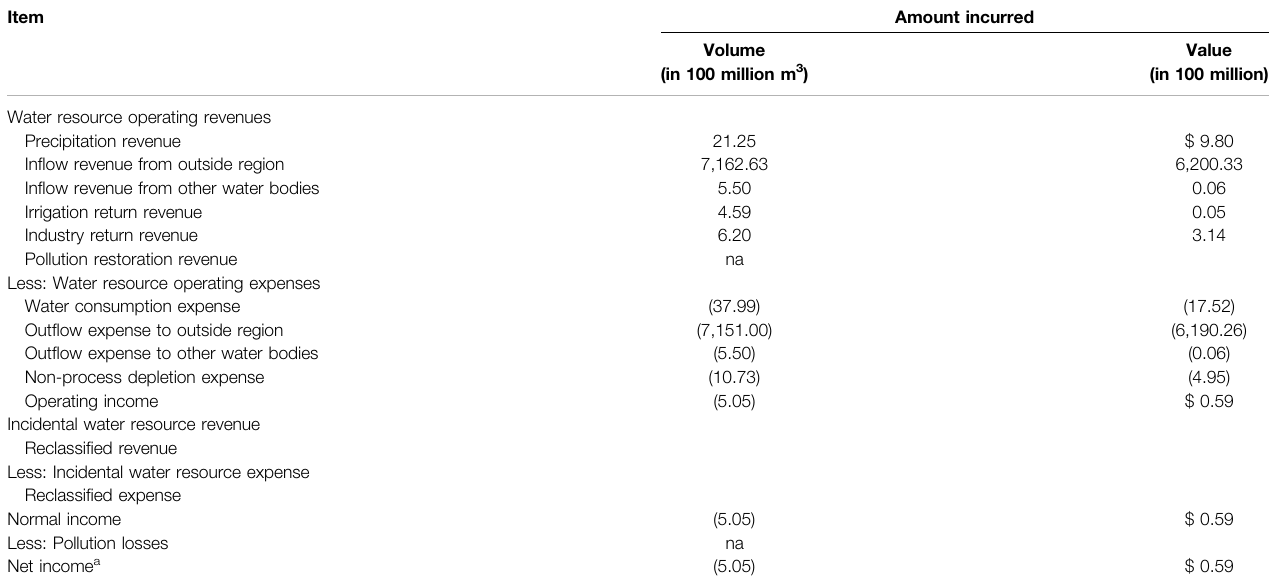
TABLE 5 | Wuhan ’ s water resource income statement in